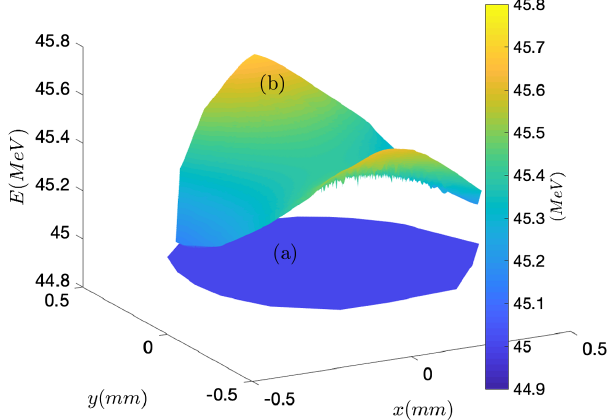
FIG. 6. (a) The flat initial energy surface around 45 MeV without uncorrelated energy spread. (b) The transverse energy distribution after interaction with the THz field correlated with the dominant quadrupole